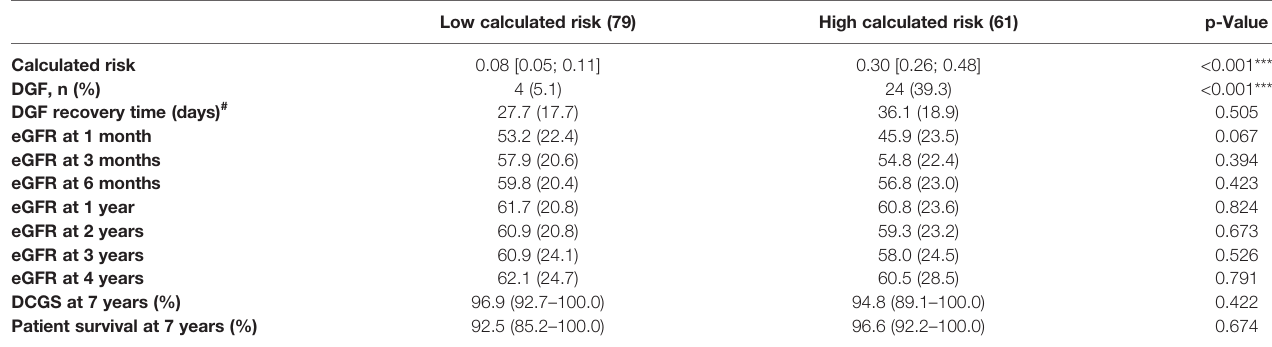
TABLE 3 | Comparison of posttransplant allograft outcome based on the calculated DGF risk derived from Irish 2010 model. Low calculated risk